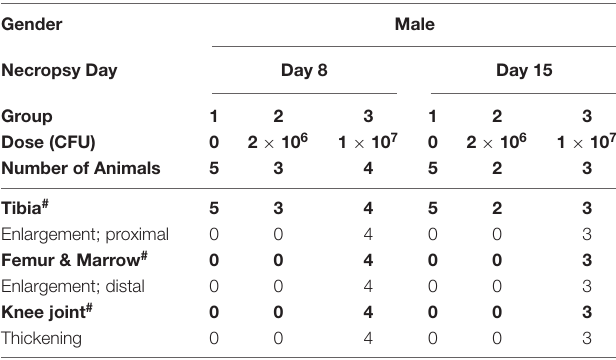
TABLE 2 | Group incidence of S. aureus intramedullary implant-related macroscopic